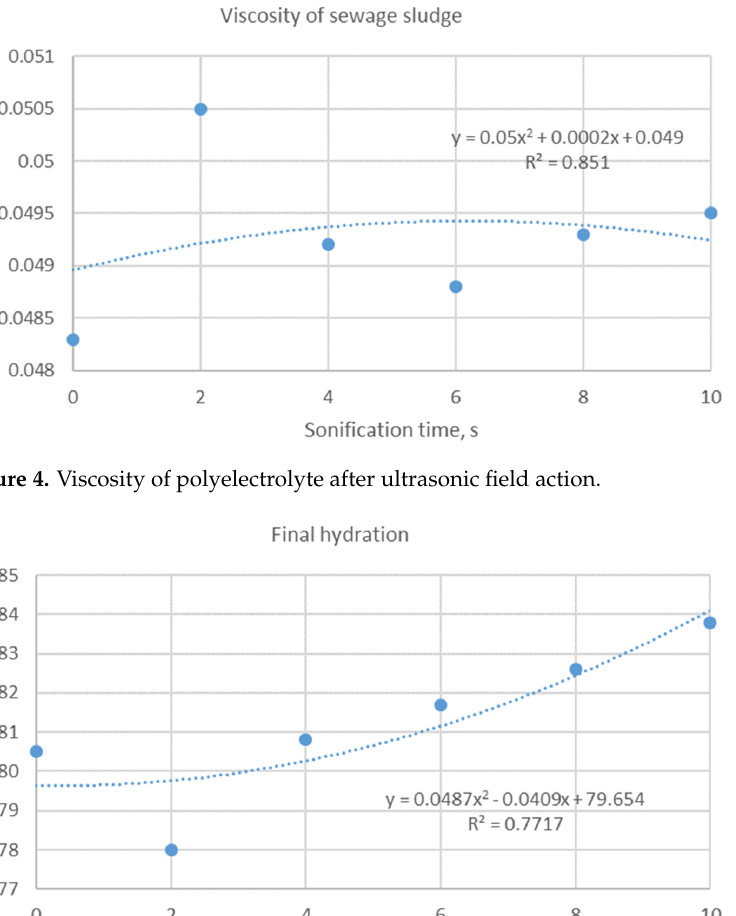
Figure 3. Capillary suction time of sewage sludge conditioned with sonicated polyelectrolyte.